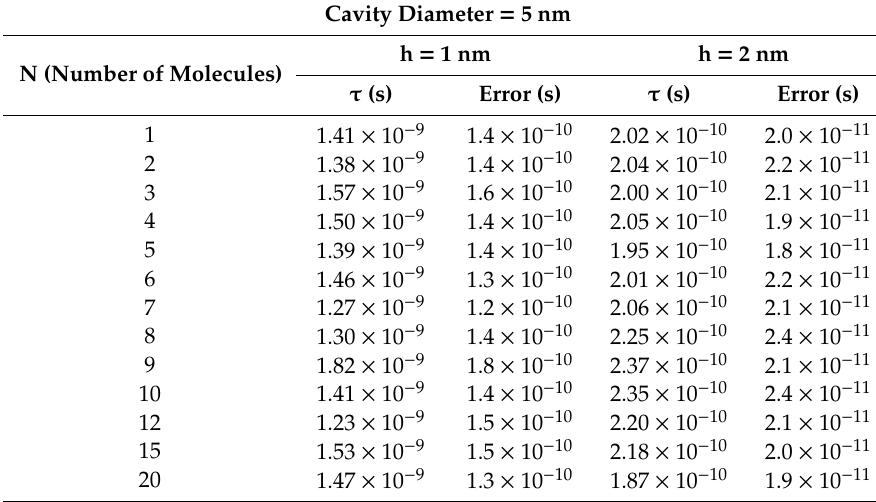
Table A3. Mean escape time ( τ ) and associated errors of di ff erent number molecules confined in a 5-nm spherical cavity for di ff erent entrance–escape hole diameters (h) calculated by the interactive random walk models for 10 2 runs.